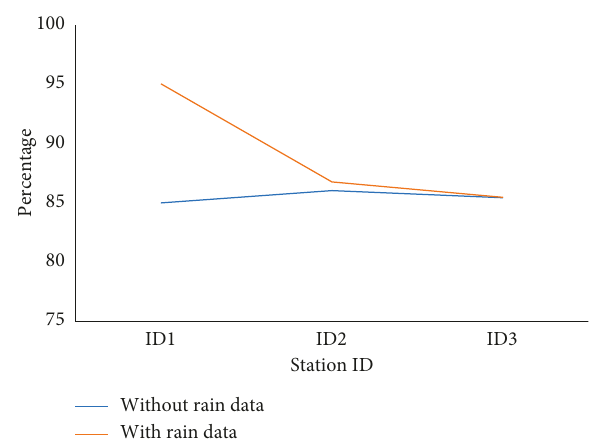
Figure 12: Comparison performance with rain factor. Table 19: Performance of model with rain